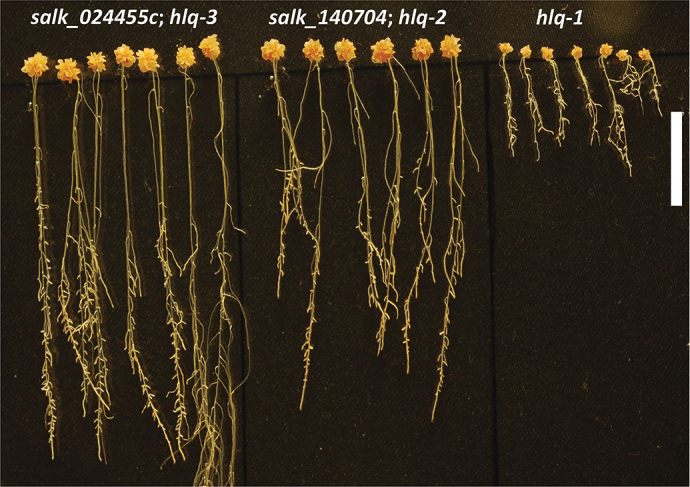
T-DNA knockout lines SALK_140704 and SALK_024455C identify two new hypomorphic alleles of hlq based on severity of shoot and root dwarfism and other pleiotropic effects on morphogenesis. Segregating mutants were plated on 0.8% sucrose minimal media and grown for 6 weeks. Bar=1cm.